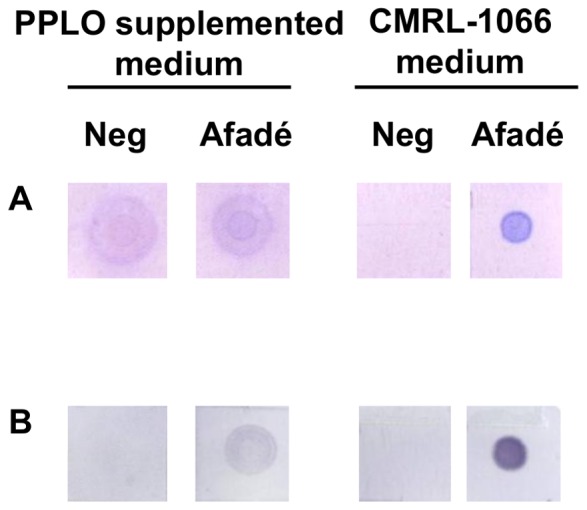
Exopolysaccharide (EPS) secretion by Mmm strain Afadé in supplemented PPLO broth and CMRL-1066 medium.EPS extracted either from Mmm culture (Afadé) or from unseeded medium used as negative control (Neg) were spotted onto a nylon membrane and either stained with a glycoprotein detection reagent (A) or immunodetected using a serum from a CBPP-positive bovine (B).